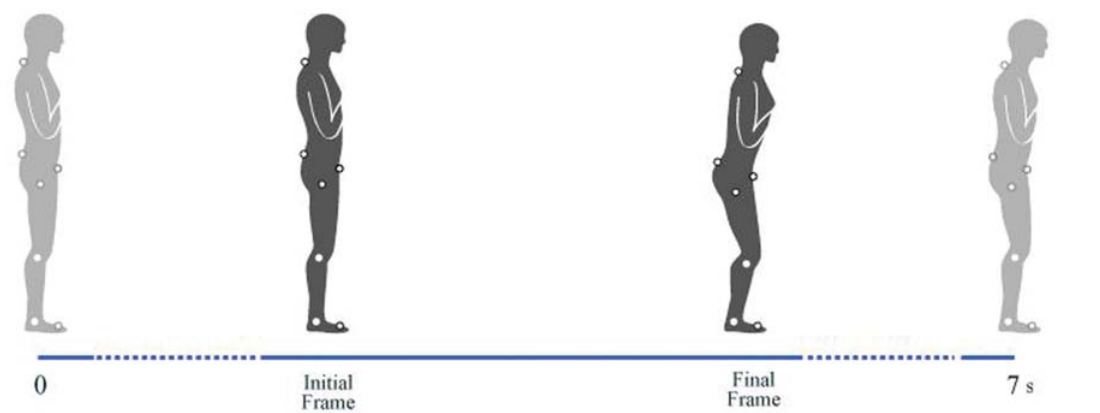
Figure 2 - Illustration showing the movement of a participant during the 7 s trial. Gray figures indicate the beginning and end of a trial; black figures indicate initial and final